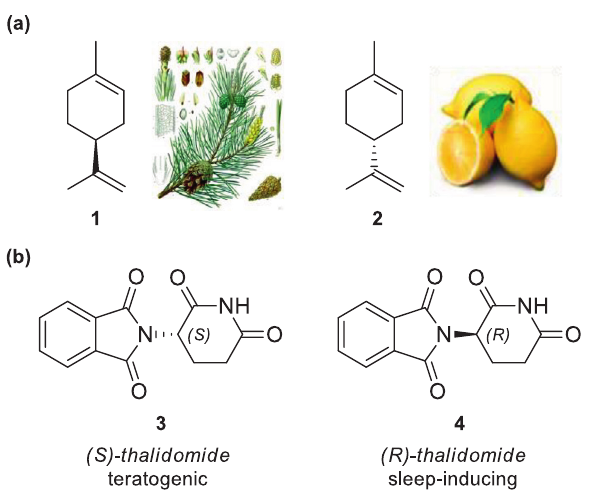
Figure 1 . (a) Limonene enantiomers and respective different fra- grances: turpentine and lemon; (b) thalidomide, the two